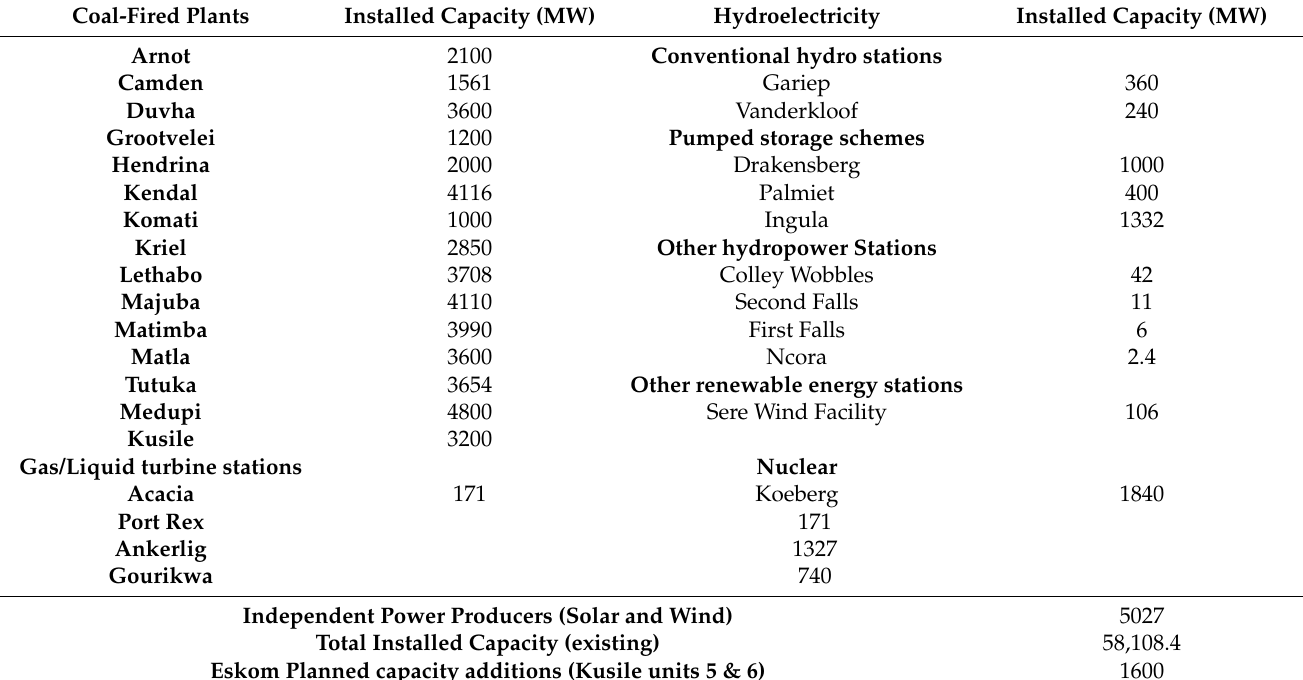
Table 1. South Africa Power Plant.